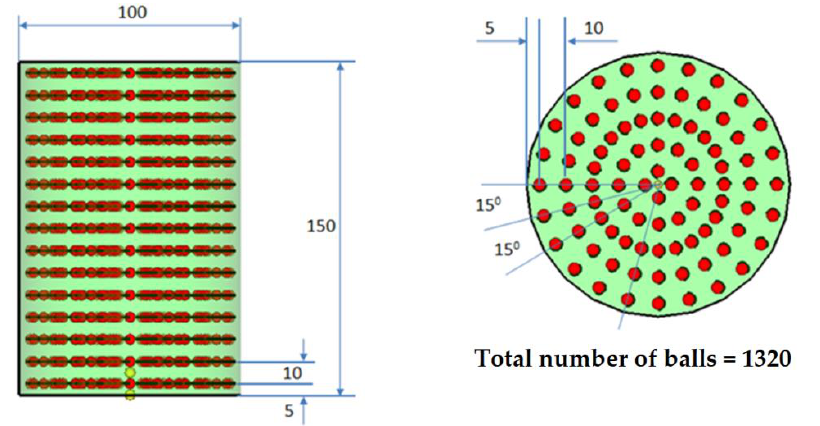
Figure 1. Physical model of the inertial damper. ( a ) Cylinder with balls ( b ) Version I with 1,320 balls. ( c ) Version II with 2040 balls.